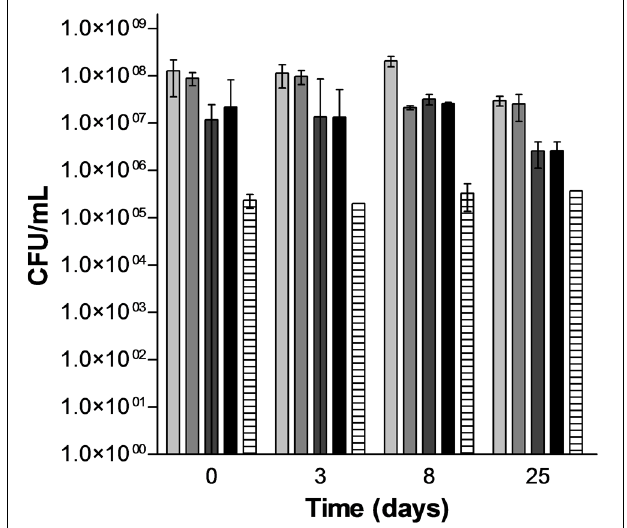
FIGURE 3 | Evolution of the population of untreated and PEF treated cells of S. cerevisiae along the incubation time. Untreated, 15 kV/cm 45 µ s, 15 kV/cm 150 µ s, 25 kV/cm 45 µ s, 25 kV/cm 150 µ